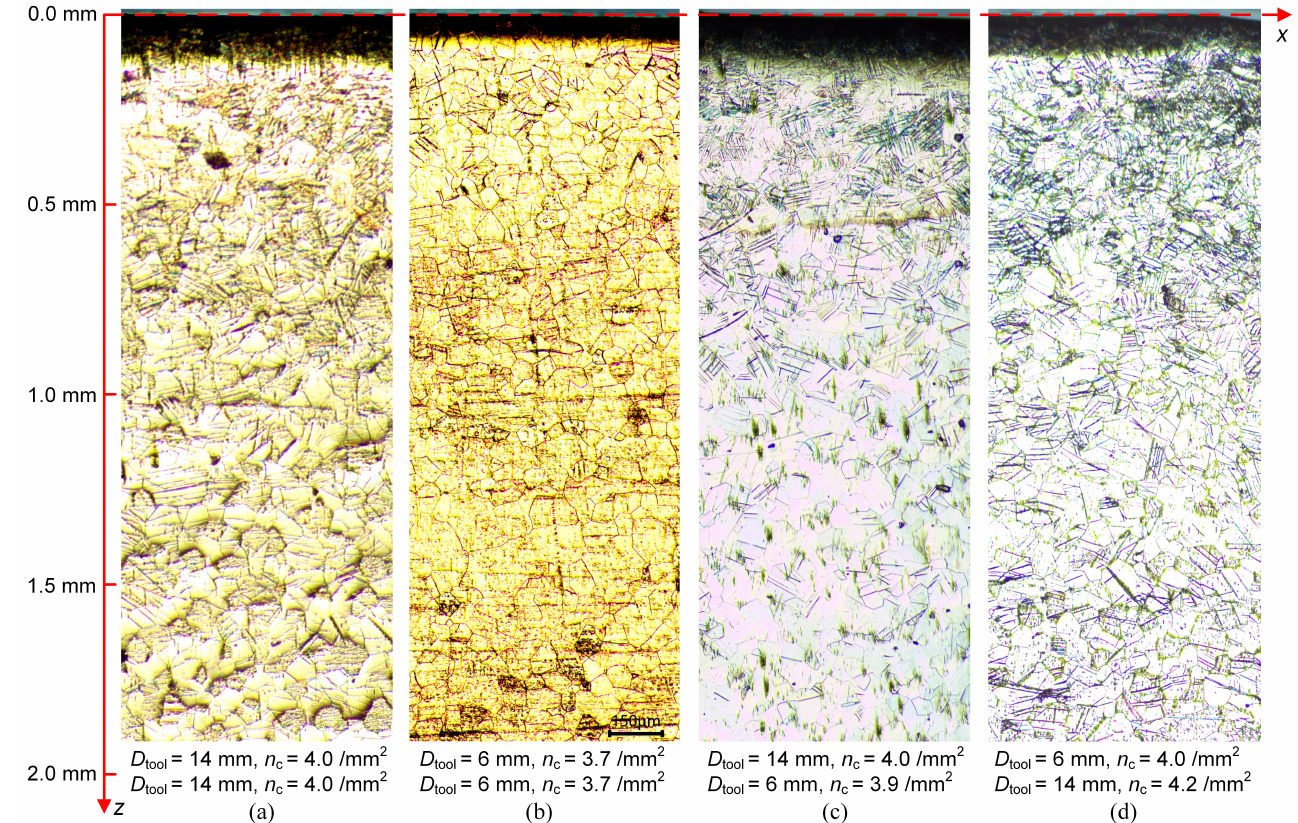
Figure 8. Microstructure near surface of hammering treated ( a ) sample 1, ( b ) sample 2, ( c ) sample 3 and ( d ) sample